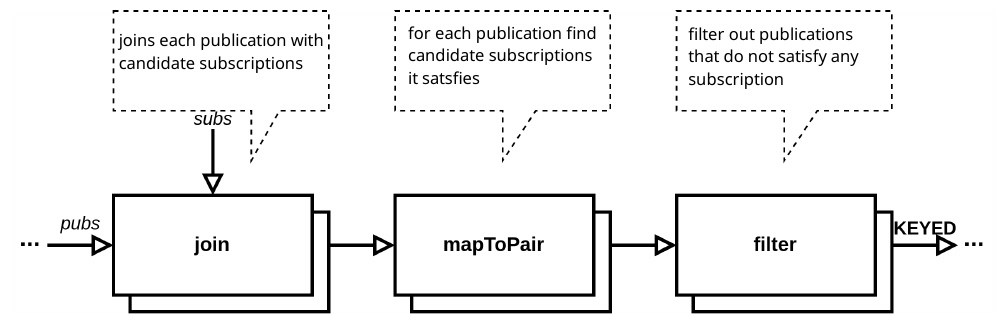
Figure 3. Relevant processing steps of the geospatial publish/subscribe